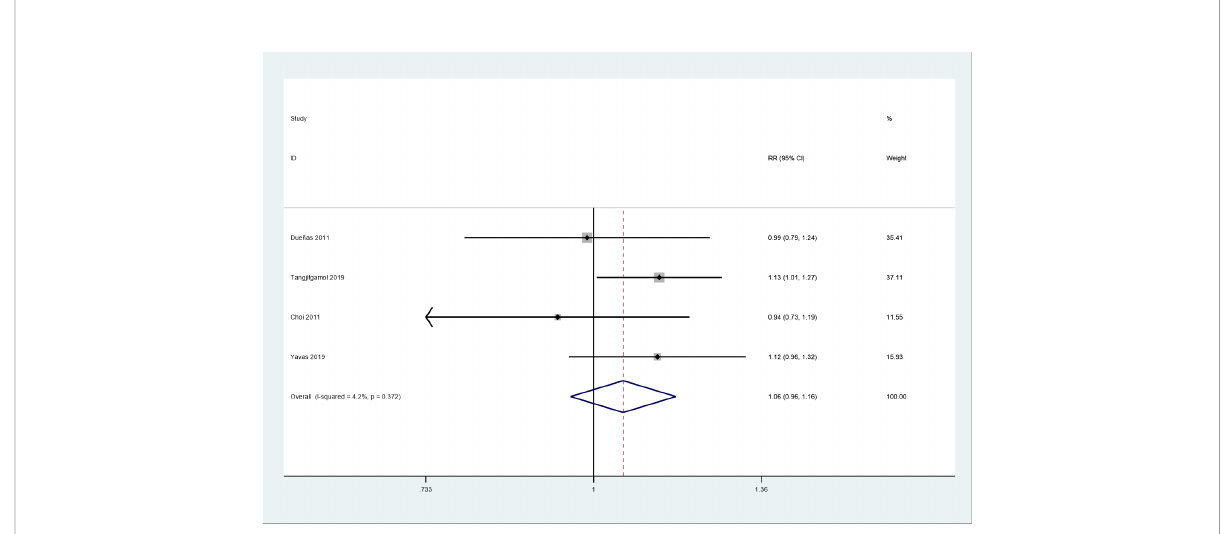
FIGURE 6 Forest plot of the complete response rate.